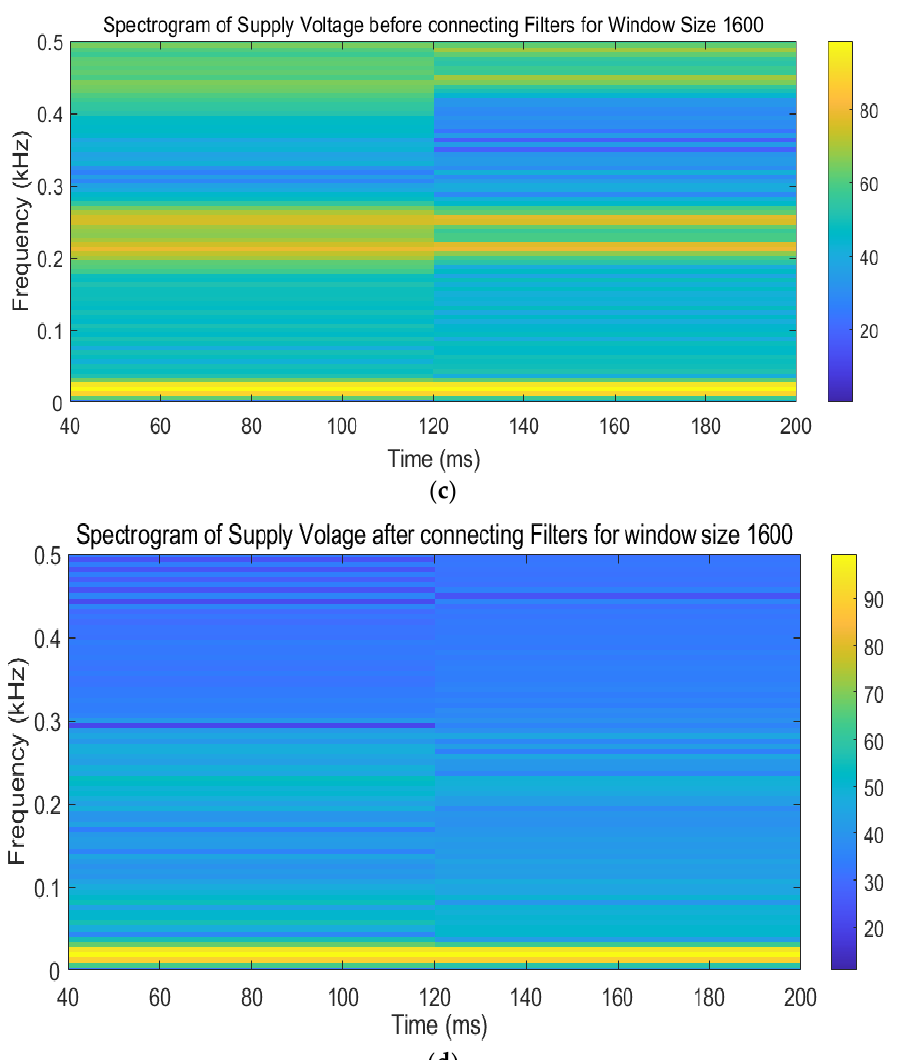
Figure 12. ( a ) STFT for supply voltage using the Hamming window of a segment length size of 120 before connecting harmonic filters. ( b ) STFT for supply voltage using the Hamming window of a segment length size of 120 after connecting harmonic filters. ( c ) STFT for supply voltage using the Hamming window of a segment length size of 1600 before connecting harmonic filters. ( d ) STFT for supply voltage using a Hamming window of a segment length size of 1600 after connecting harmonic filters.